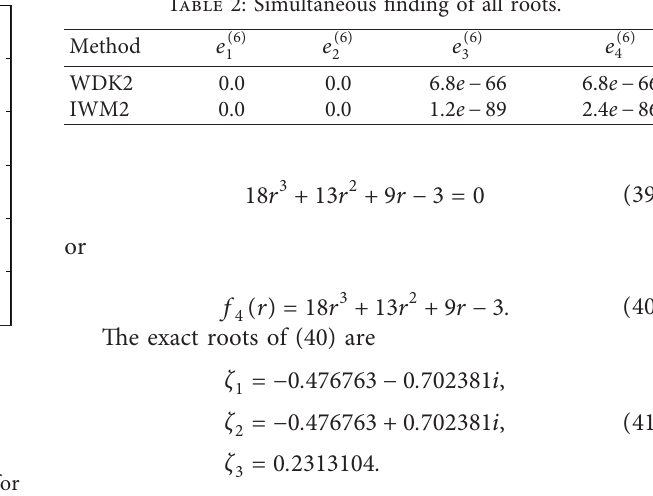
( r ) − f ( r ) , respectively. 3 6